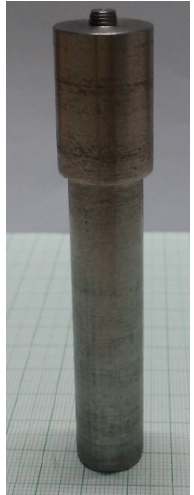
Figure 2. FSW tool. Figure 2. FSW tool.